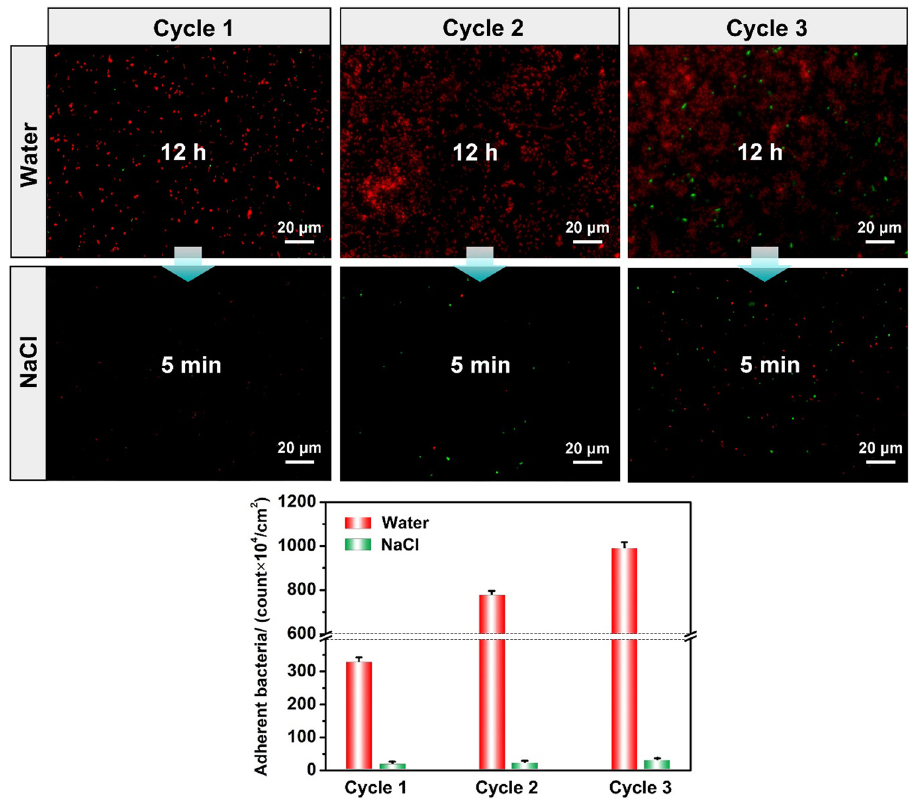
Figure 8: Bacterial killing and release property of PSBMA - P ( HEAA - co - METAC ) surfaces against E. coli during three cycles of the surface